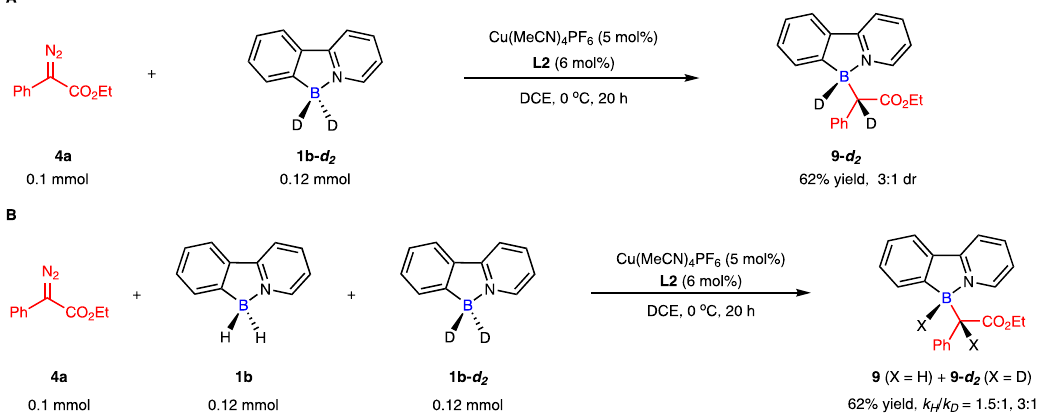
Fig. 9 Isotope labeling experiments. A Deuterium labeling experiment. B KIE